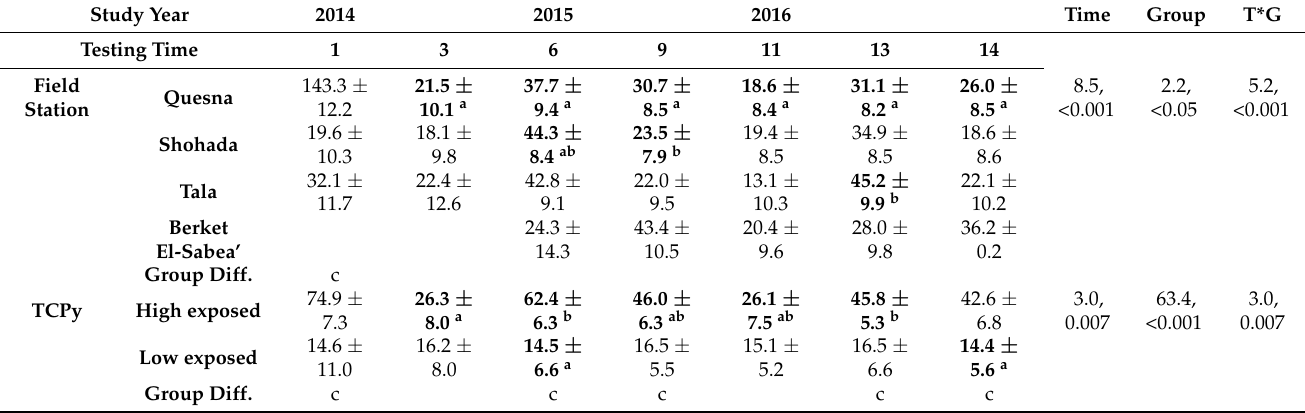
Table A1. Urinary TCPy levels (ng TCPy/mg creatinine, least squares mean ± SE) at the 7 timepoints where TCPy was assessed, stratified by high and low CPF exposure groups and field stations. Shaded areas indicate the time of CPF